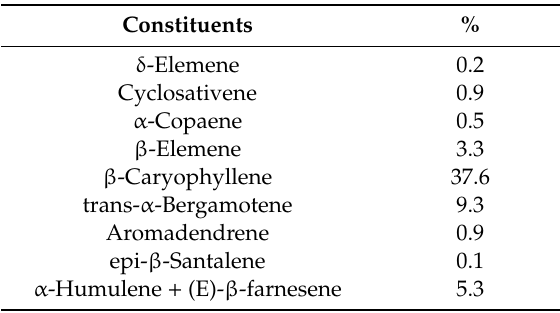
Table A1. Chemical composition of the oleoresin volatiles of tree C. reticulata Ducke by GC-MS described by Santos-Guimar ã es et al.